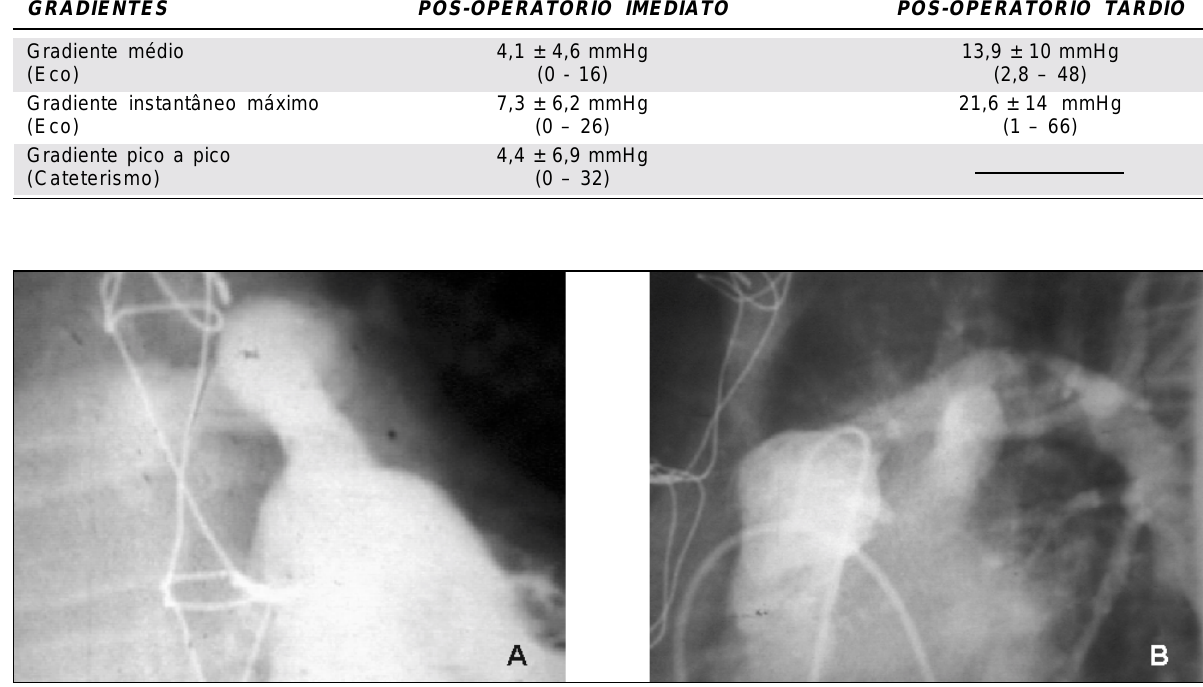
Fig. 6 - Ventriculografia direita no paciente com gradiente de pico de 66mmHg. Visualiza-se estenose tubular difusa do conduto. A- Ventriculografia em oblíqua anterior direita. B- Mesma imagem em oblíqua esquerda.